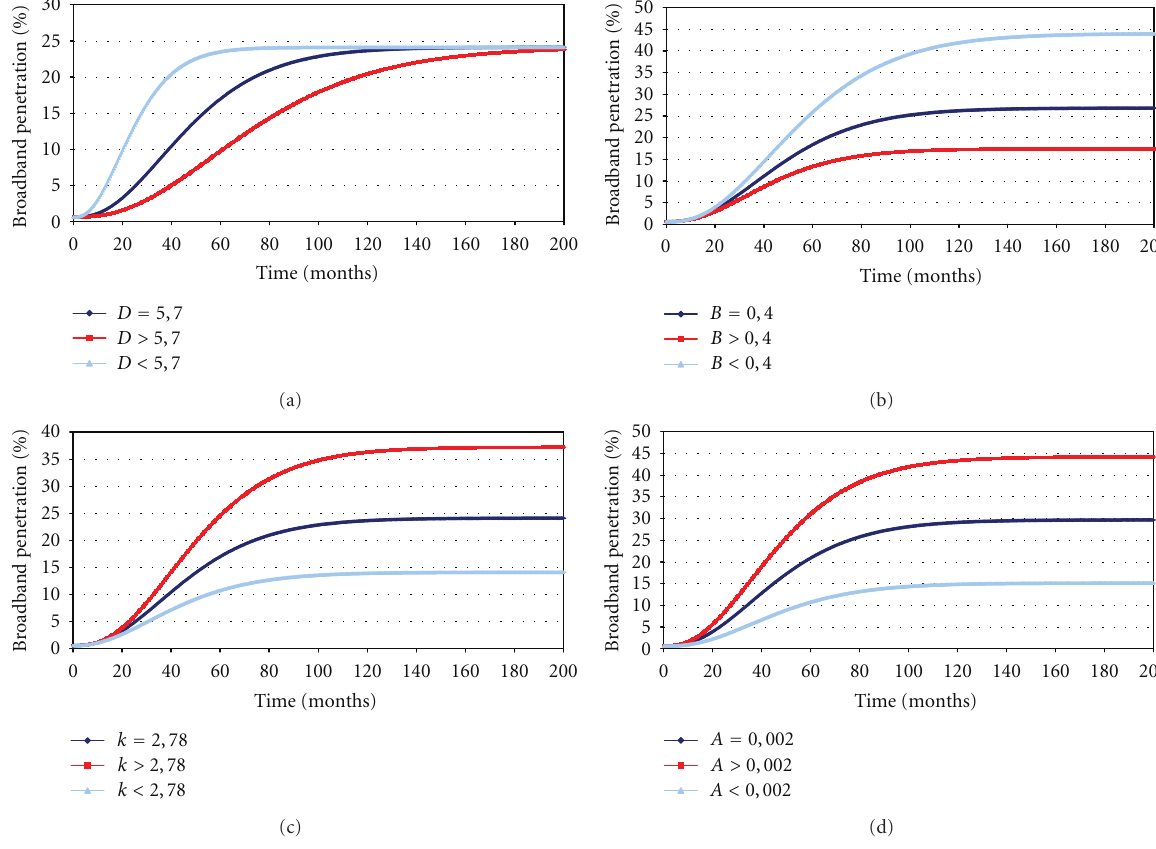
Figure 2: The influence of parameters on the model